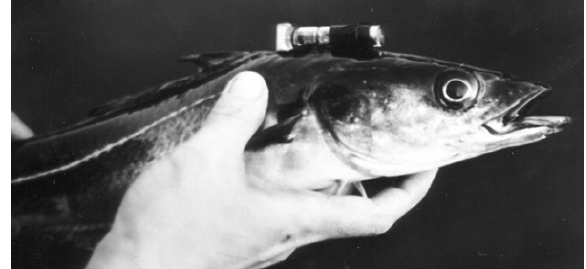
Figure 11: Controversial setup for fish